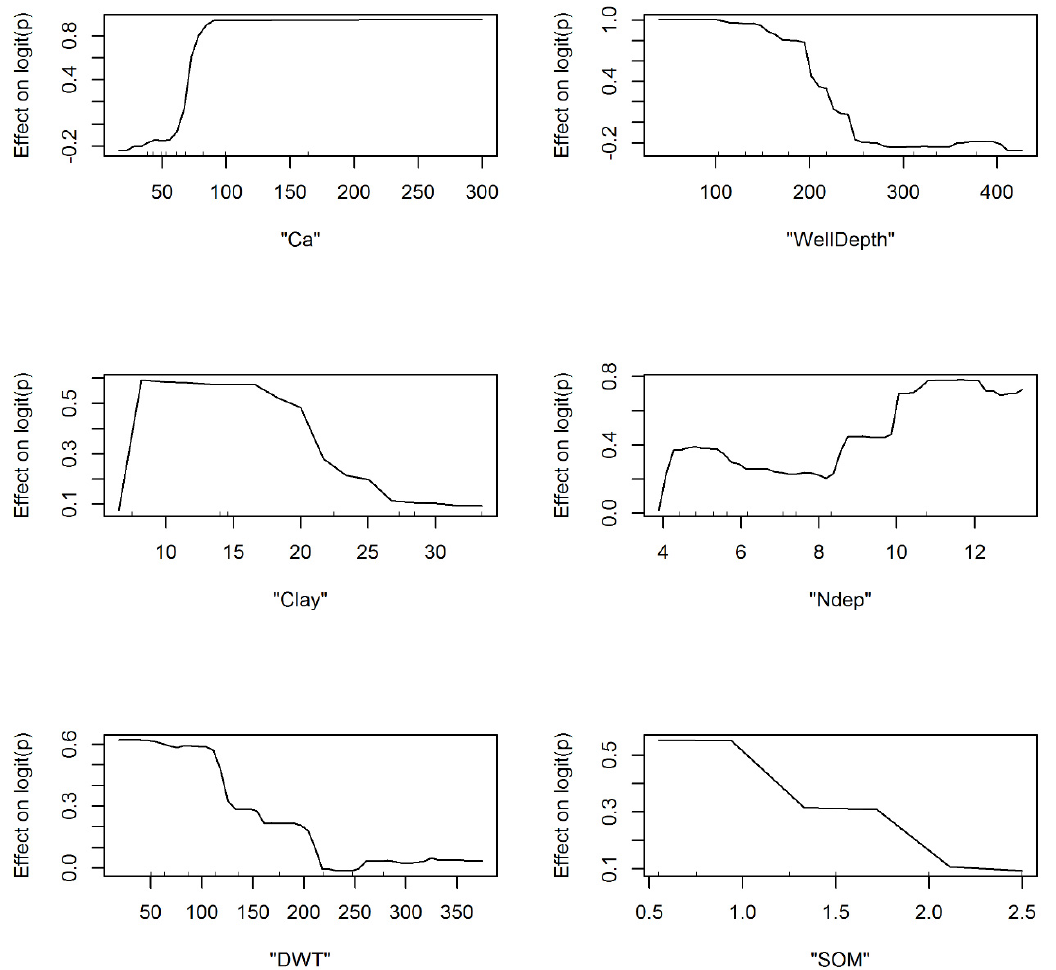
Figure 4. Sensitivity of Salient Model Parameters and their Effect on Logit Computation in the Random Forest Model.